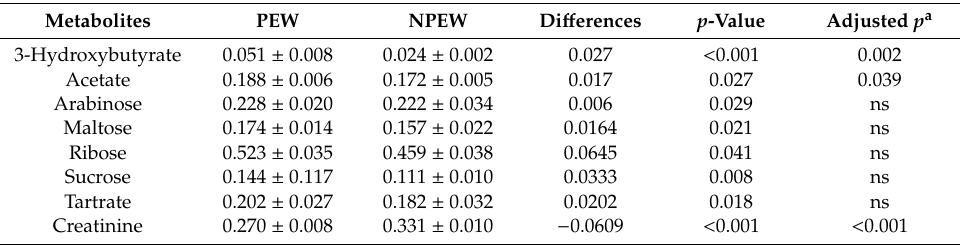
Table 3. Comparison on the relative concentrations of discriminant metabolites between PEW and NPEW identified by 1 H NMR.